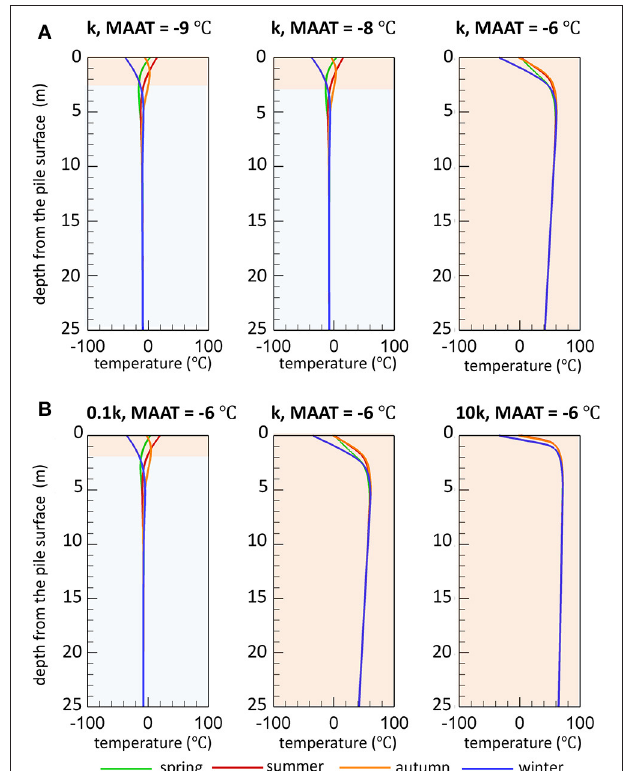
FIGURE 6 | Spatial distribution of temperature (T) vs. depth in a WRP at the end of each season after 50 years, demonstrating the sensitivity of temperature profiles and permafrost development to (A) climate change and (B) pyrite reactivity. Based on the temperature profiles at the end of each season, the light orange and blue zones represent the estimated active layer thickness and continuous permafrost region, respectively ( k refers to k ref FeS